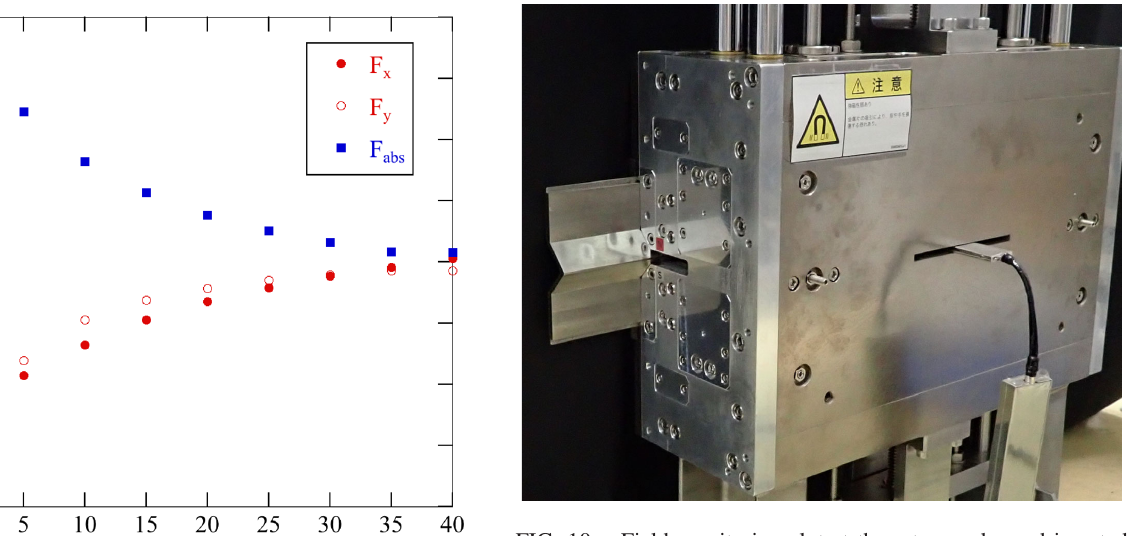
FIG. 10. Field monitoring slot at the return-yoke and inserted NMR